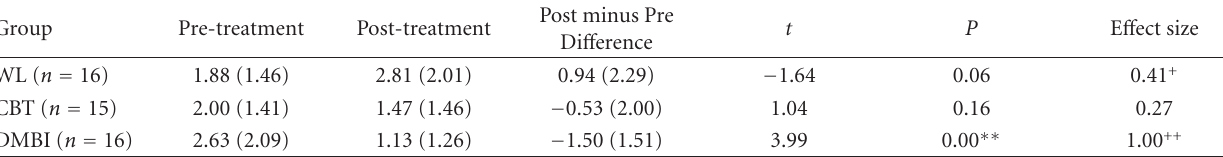
Table 2: Psychiatrist rating on the sleep items of HRSD at pre- and post-treatment. Group Pre-treatment